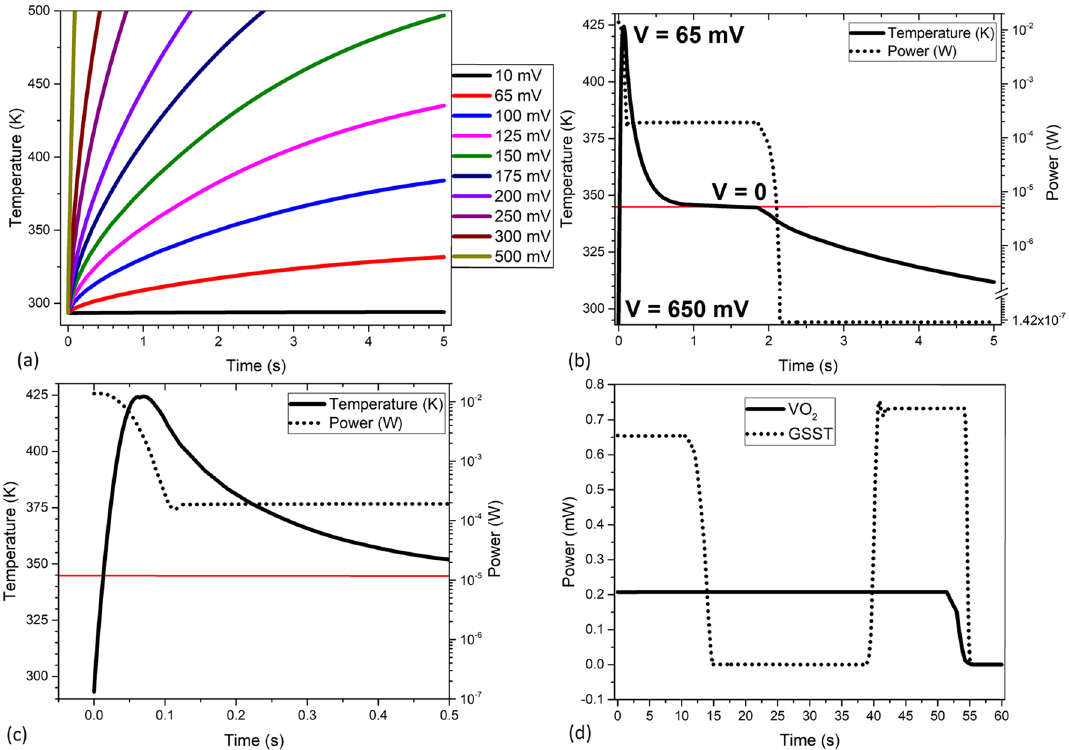
Figure 4. ( a ) Graph of the voltage dependence on the time to reach threshold temperature. ( b ) Temperature and power curves during numerical study applying 550 mV, stepping down to 65 mV, and removing the voltage.